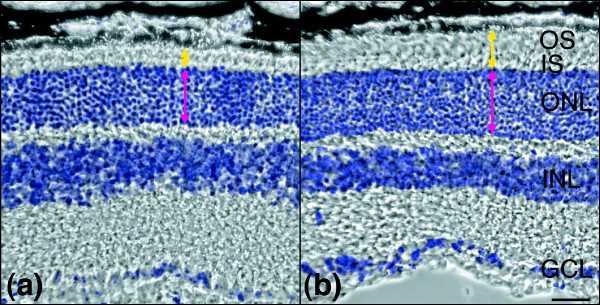
Comparative histology of 1-month-old c57 and P347S retinas. Eyes from 1-month-old c57 and P347S (mutant pro347ser RHO transgene) animals were fixed in 4% paraformaldehyde, 12 μm cryosections cut, and nuclei counterstained with 4',6-diamidine-2-phenylindole-dihydrochloride (DAPI). Phase contrast and fluorescent dark field (DAPI, false colored) microscopic images were overlaid to display histology of (a) P347S and (b) c57 retinas. Combined thicknesses of photoreceptor outer an inner segments (yellow arrows) and outer nuclear layer (magenta arrows) are indicated. Scale bar: 25 μm. GCL, ganglion cell layer; INL, inner nuclear layer; IS, photoreceptor inner segments; ONL, outer nuclear layer; OS, photoreceptor outer segments.